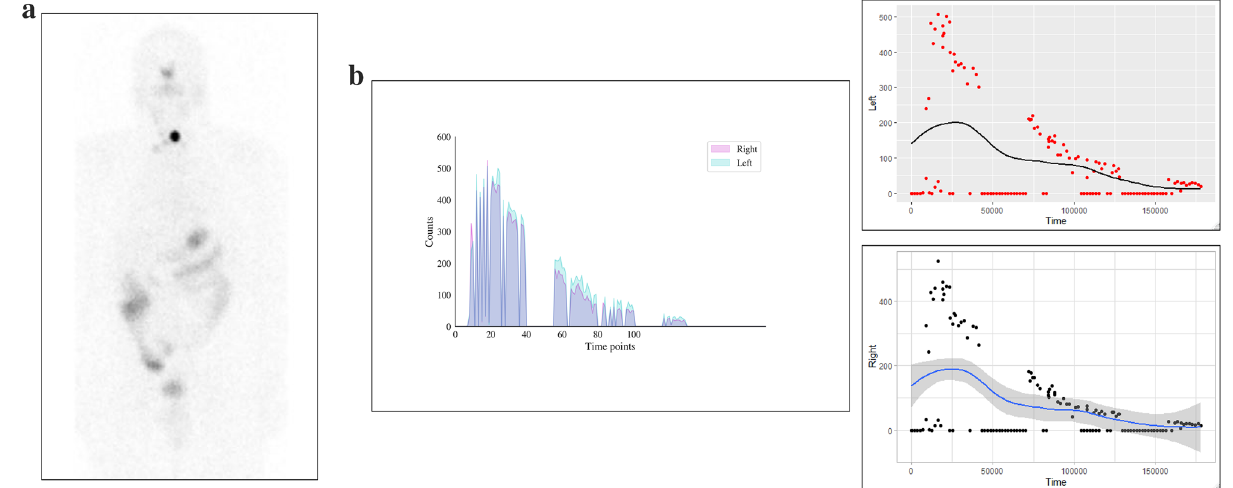
Figure 3. ( a ) First DTC Patient (Patient 3) Whole body planar image showing intense uptake in the neck at the site of remnant and physiological uptake in the bowel, nasopharynx and bladder. ( b ) First DTC Patient (Patient 3)-I-123 COTI measurements : Left- Superimposed right and left side over time points, right upper- left side COTI measurements over time in seconds , right lower— right side COTI measurements over time in seconds. ( c ) First DTC Patient (Patient 3): Left— Post-131 planar image, Right -Post-131 SPECT/CT showing bilateral areas of intense uptake. ( d ) First DTC Patient (Patient 3)-I-131 COTI measurements : Left- Superimposed right and left side over time points, right upper- left side COTI measurements over time in seconds , right lower— right side COTI measurements over time in seconds.